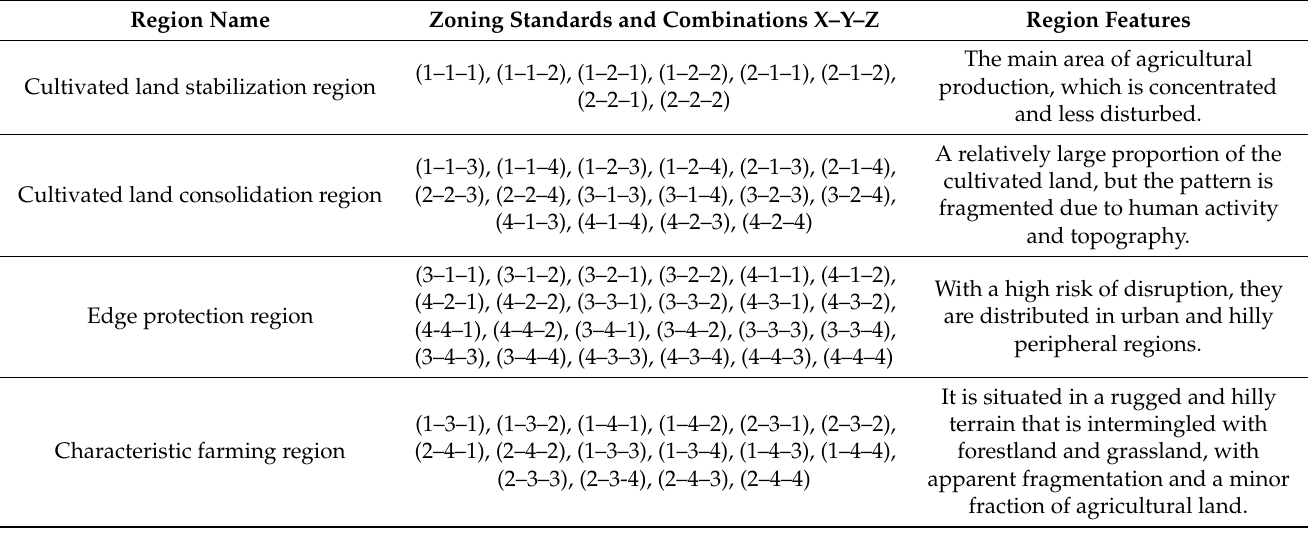
Table 2. The rules of cultivated land zoning